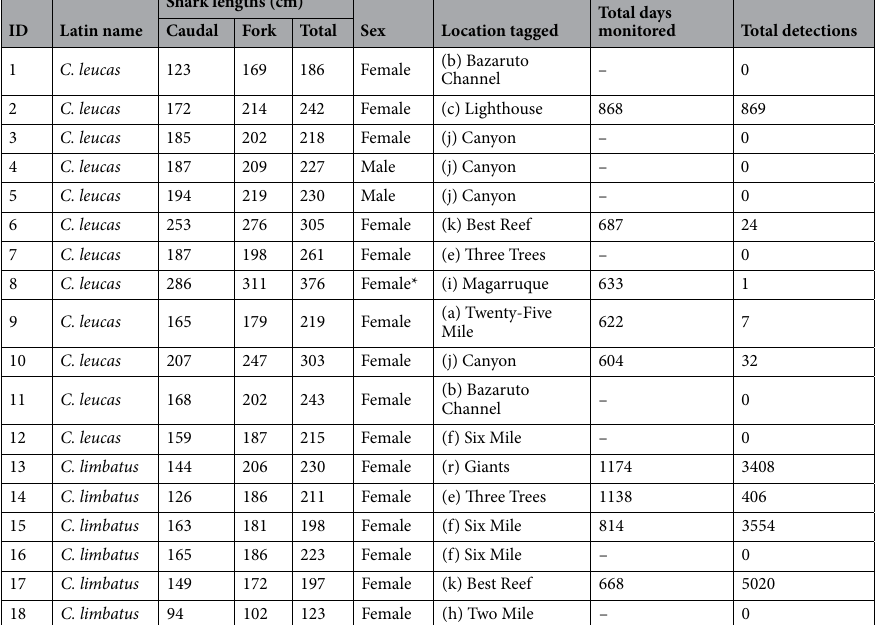
Table 1. Details of the tagged sharks including their Latin Name, ID code, Sex, and length of the tagged sharks, tagging location and date, monitoring duration, and total, unfiltered, detections for each of the acoustic receivers. The asterisk denotes a pregnant shark in late stage pregnancy at time of